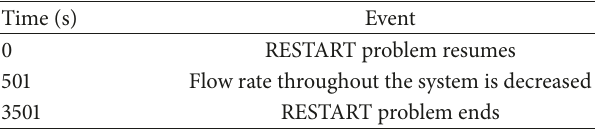
Table 9: Events scheduled for the RESTART problem. Table 10: Summary of transient cases